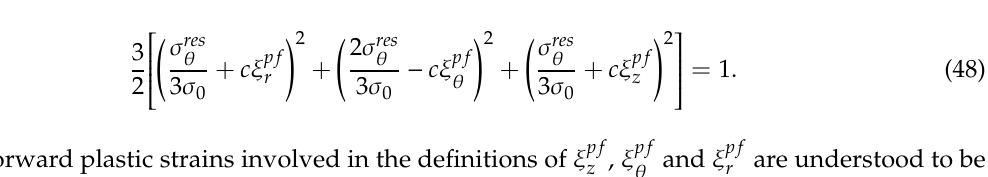
Figure 5. Distribution of the residual circumferential stress near the inner radius of an a = 0.3